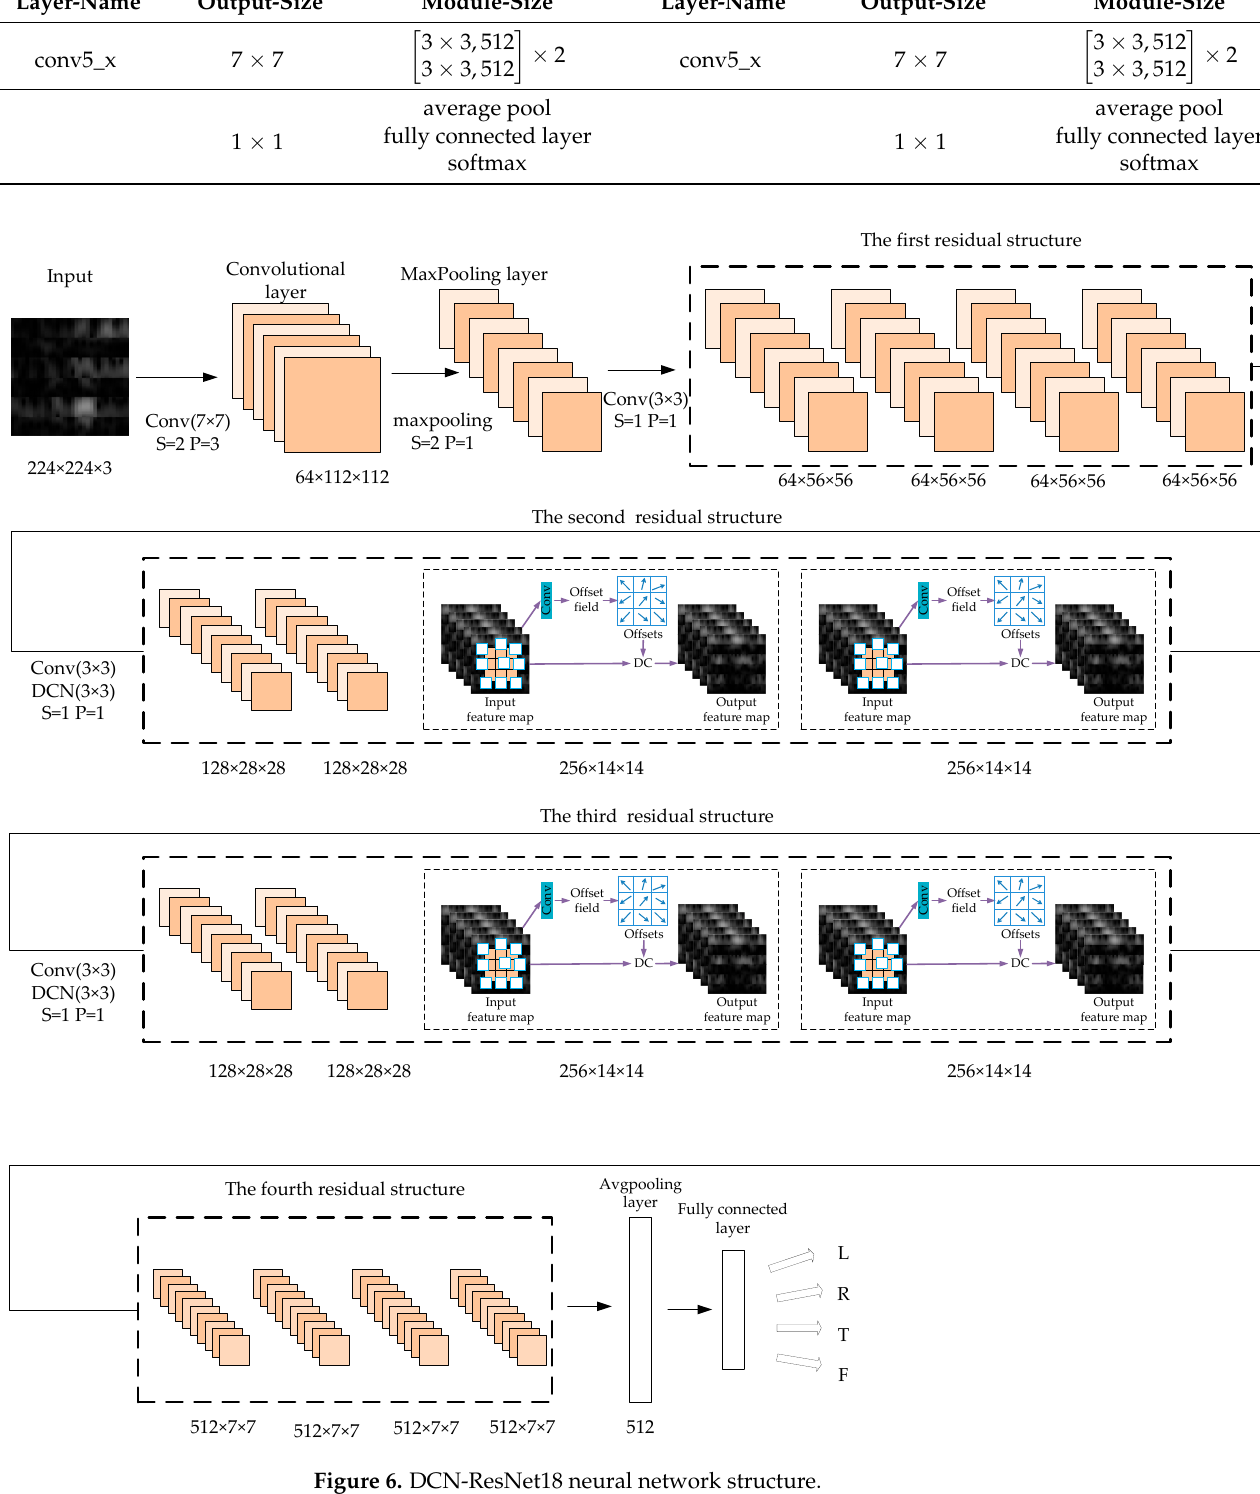
Figure 7. Identification block diagram.